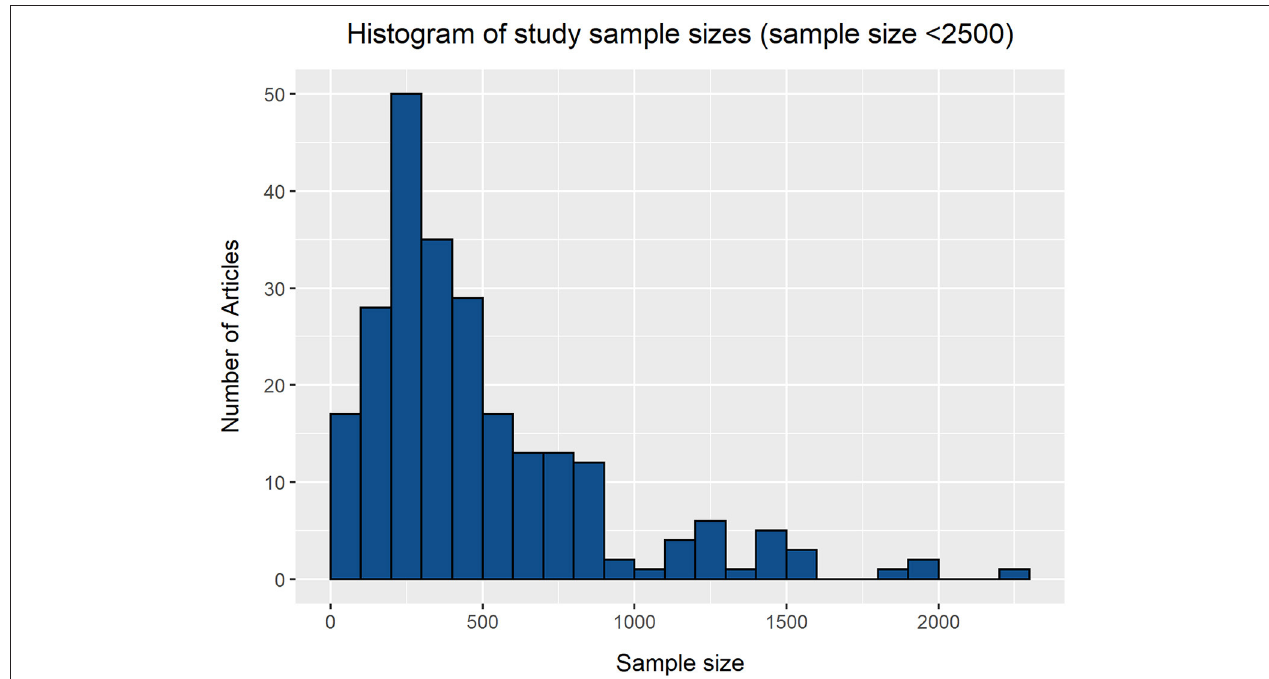
FIGURE 2 | Histogram showing the distribution of sample size, for household level data, across the articles reviewed. Only articles with a sample size of < 2,500 are presented. There were 16 articles with a sample size > 2,500, ranging from 2,710 to 8,938.